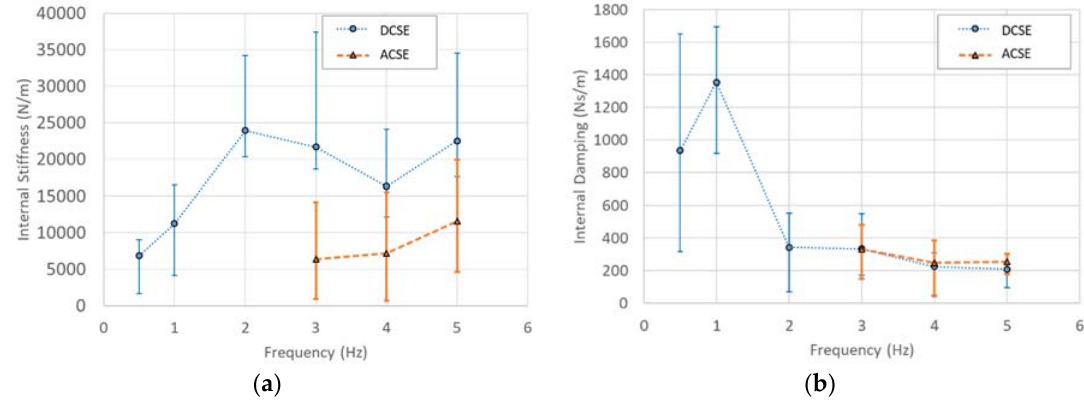
Figure 18. Estimated internal ( a ) stiffness and ( b ) damping versus excitation frequency.